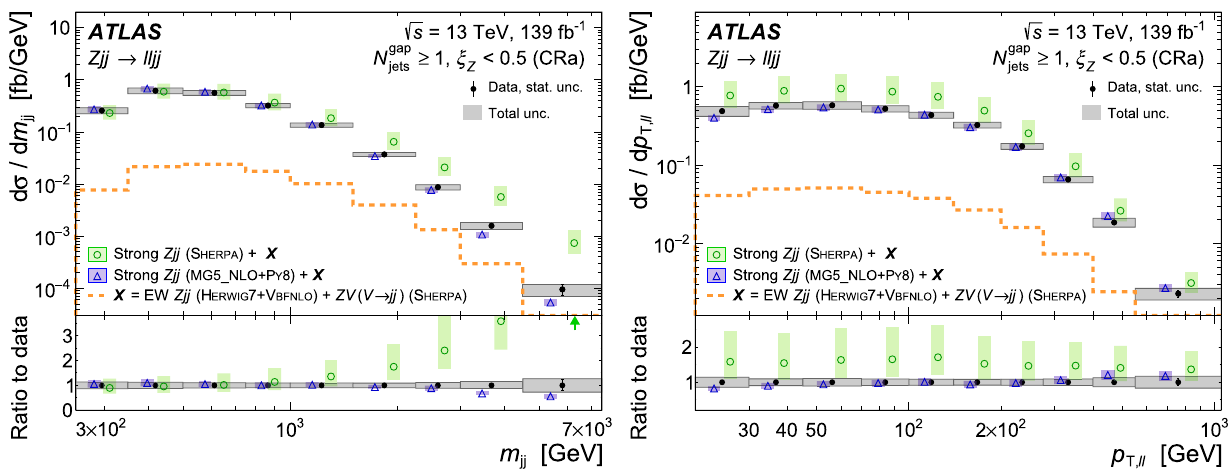
Fig. 9 Differential cross-sections measured in CRa for inclusive Zjj production as a function of m jj (left) and p t ,(cid:3)(cid:3) (right), where CRa is defined ≥ 1 and ξ < 0 . 5. The unfolded data are shown as black points, with the statistical uncertainty represented by an error bar and the by N gap Z jets total uncertainty represented as a grey band. The data are compared with theoretical predictions constructed from different strong Zjj predictions provided by Sherpa (green) and MG5_NLO+P y 8 (blue). Uncertainty bands are shown for the two theoretical predictions. Each theory prediction is slightly offset from the bin center to avoid